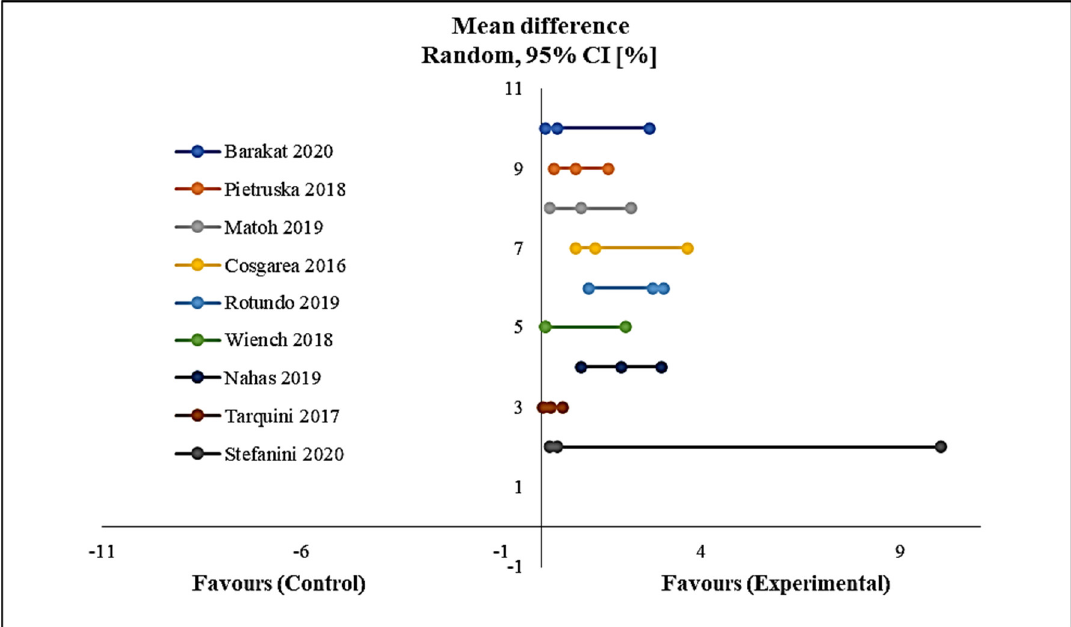
Figure 6. Forest plot shows mean reduction in recession depth. CI, confidence